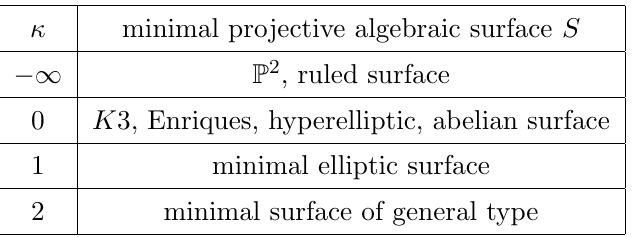
Table 3 . The (cid:12)rst column is the Kodaira dimension (cid:20) of the surface S. The second column presents the Enriques-Kodaira classi(cid:12)cation of minimal projective algebraic